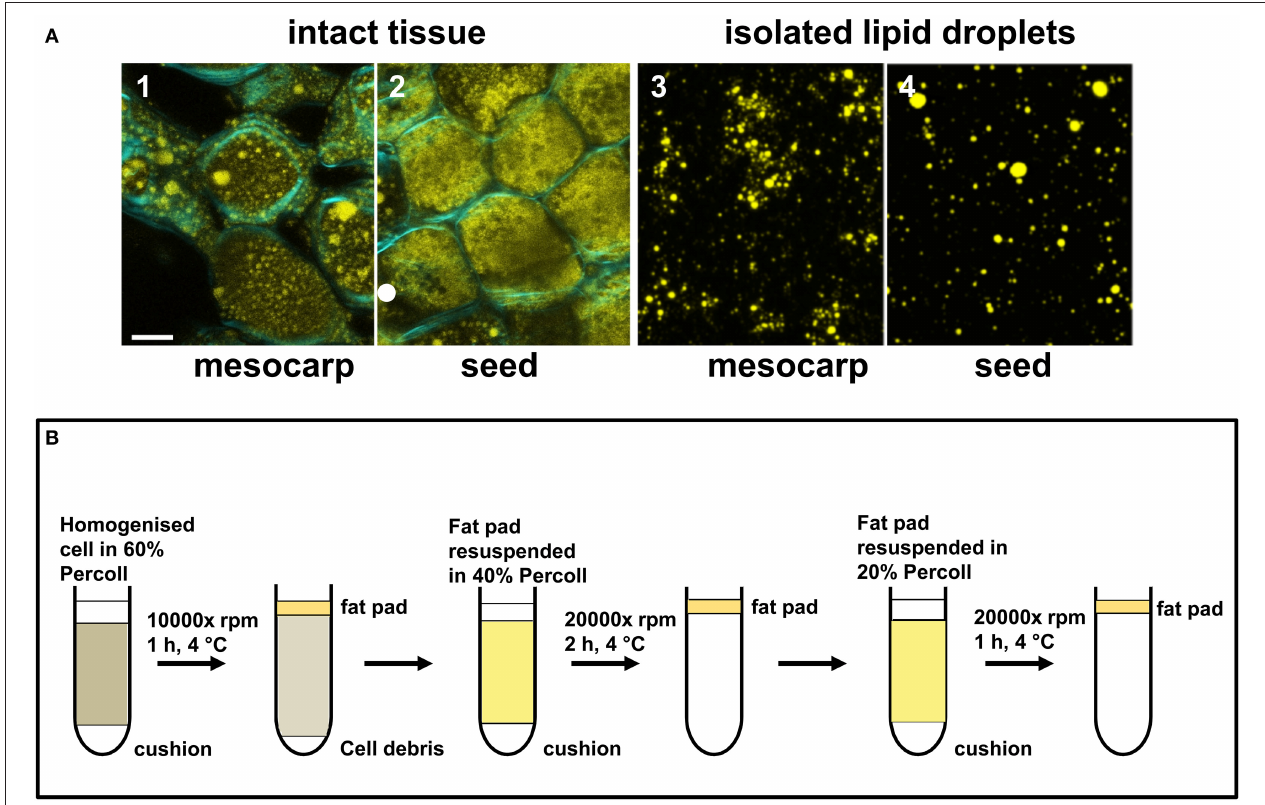
FIGURE 2 | Isolation of LDs from Triadica sebifera mesocarp and seed kernel. (A) Confocal images showing the presence of LDs in the intact tissues of mesocarp (1) and seed kernel (2) at the stage III of fruit development (Scale bar = 10 µ m). The “fat pads” isolated from T. sebifera mesocarp (3) and seed kernel (4) tissues were stained by Nile Red, which illustrates the presence of intact LDs (Scale bar = 10 µ m). (B) A schematic summary of the procedures used for the isolation and purification of